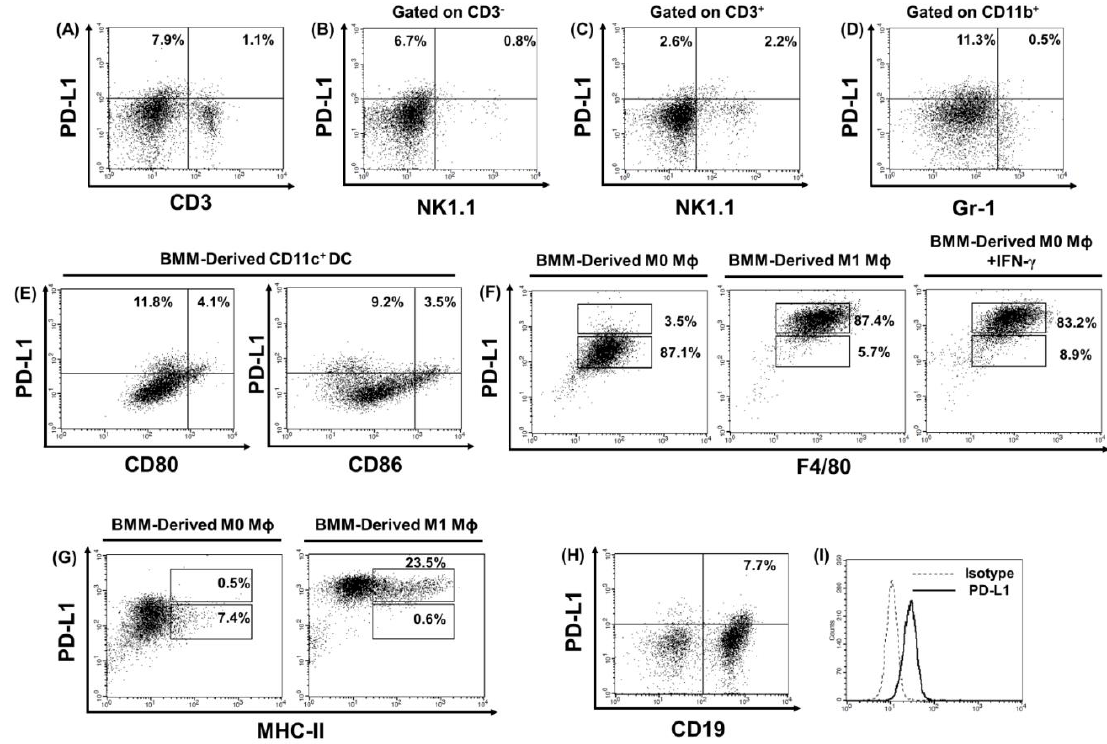
Figure 3. PD-L1 expression on various immunocytes from splenocytes of mice treated with PEK protein vaccine and bone marrow-derived cells, and TC-1 tumor cells analyzed by flow cytometry. ( A ) Representative figures depict PD-L1 expression on T lymphocytes. ( B ) PD-L1 expression on natural killer (NK) cells of splenocytes. ( C ) PD-L1 expression on natural killer T (NKT) cells in